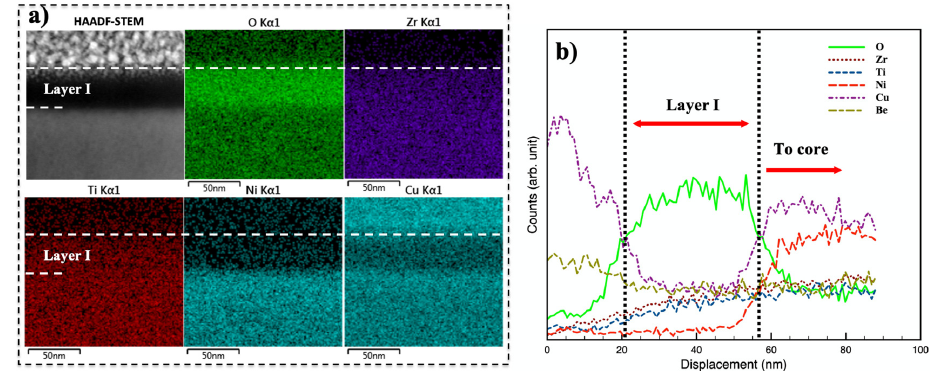
Figure 5. STEM-EDS chemical analysis for the topmost layer on Vit1b after CCT at 350 ◦ C for 40 h: ( a ) maps and ( b ) line profiles across the layer. Note that EDS line profiles were plotted based on X-ray counts (rather than concentrations).